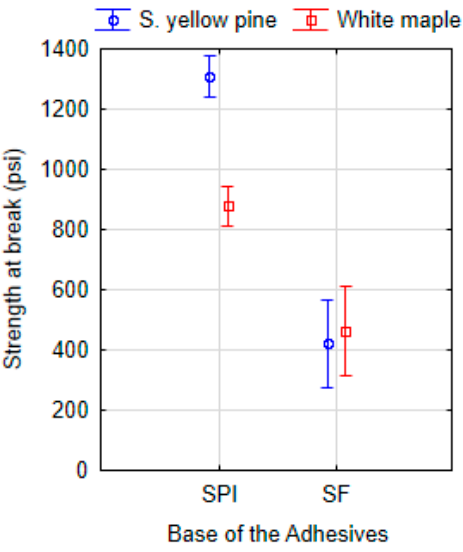
Figure 6. ANOVA (Tukey unequal N HSD) of the dry shear strength at break point according to the base of adhesives: soy protein isolate (10 types: 10-SPI-PEO, 10-SPI-PEO-L, 9-SPI-PEO, 9-SPI-PEO-L, 9-SPI-HPMC, 9-SPI-HPMC-L, 9-SPI-C, 9-SPI-C-L, 9-SPI-PVA, 9-SPI-PVA-L) and soy flour base (2 types: 15-SF-C, 15-SF-C-L).